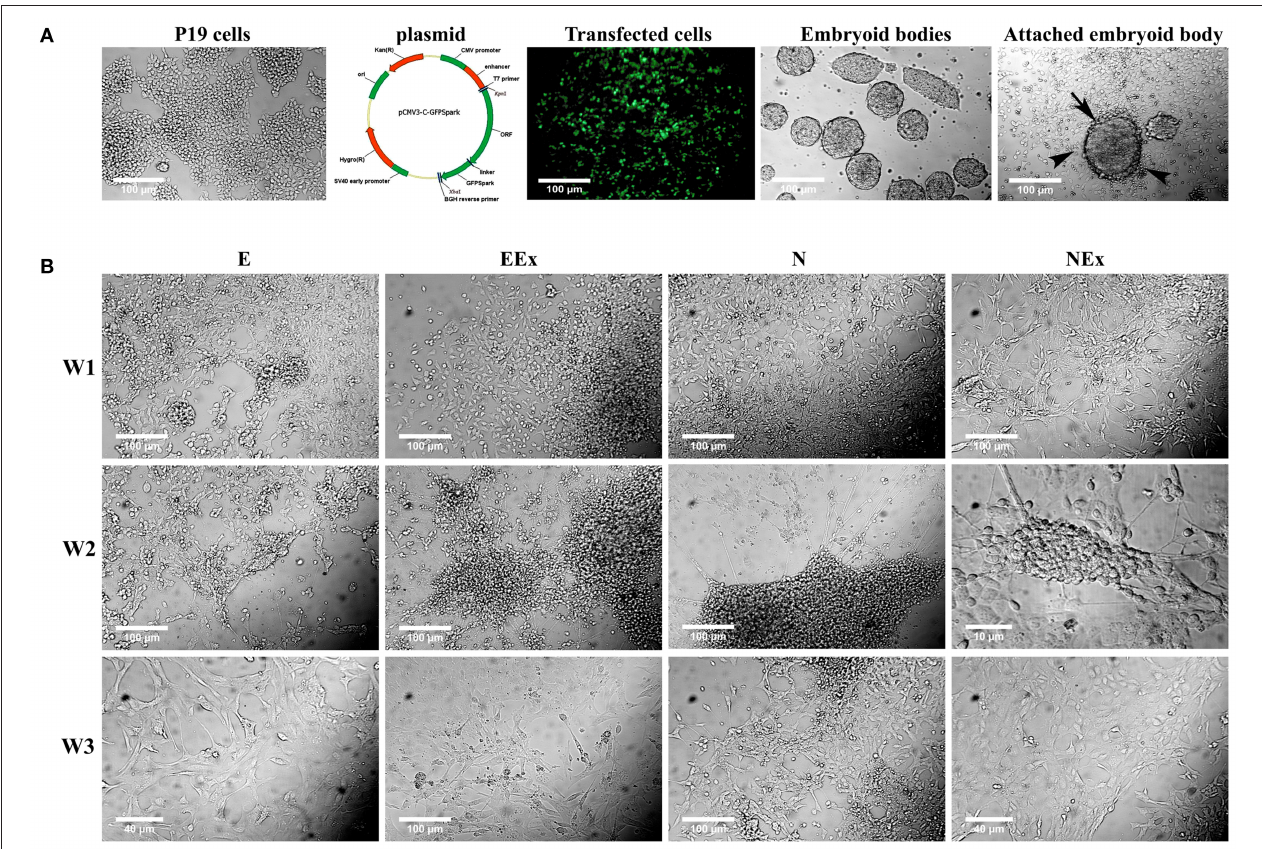
FIGURE 1 | Initial morphological evaluation of neuronal phenotype. (A) P19 EC cells were stably transfected, and GFP + EBs transferred on gelatin-coated culture dishes. Attached EBs (arrow) and the cells getting out radially (arrowheads) from them were then exposed to four various conditions. (B) Visual examinations of the photomicrographs confirmed that in all experimental groups, the neuronal phenotype was mainly appeared in the second week of the differentiation protocol, while it changed to non-neuronal appearance in the third week. The differentiated neuron-like cells have small cell bodies and numerous processes which form a cellular network with each other. E (empty), EBs transfected with pCMV3-GFPSpark vector; EEx (empty/extract), EBs transfected with pCMV3-GFPSpark vector and treated by extract; N (Nurr), EBs transfected with pCMV3-NR4A2-GFPSpark vector; NEx (Nurr/extract), EBs transfected with pCMV3-NR4A2-GFPSpark vector and treated by extract; W1, W2, W3, week 1, 2, 3,